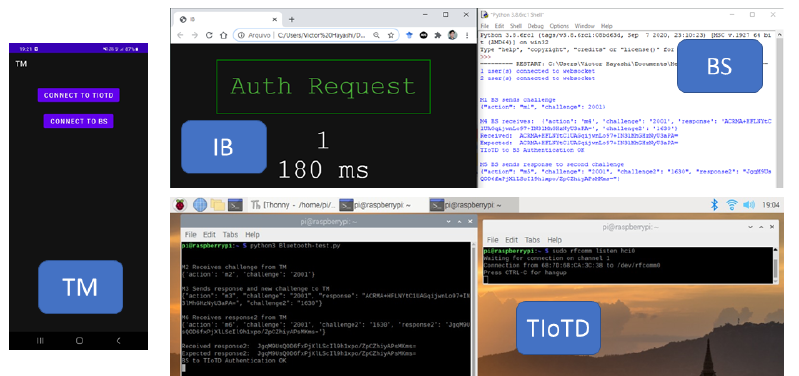
Figure 10. Proposed protocol with SHA-256 hash.